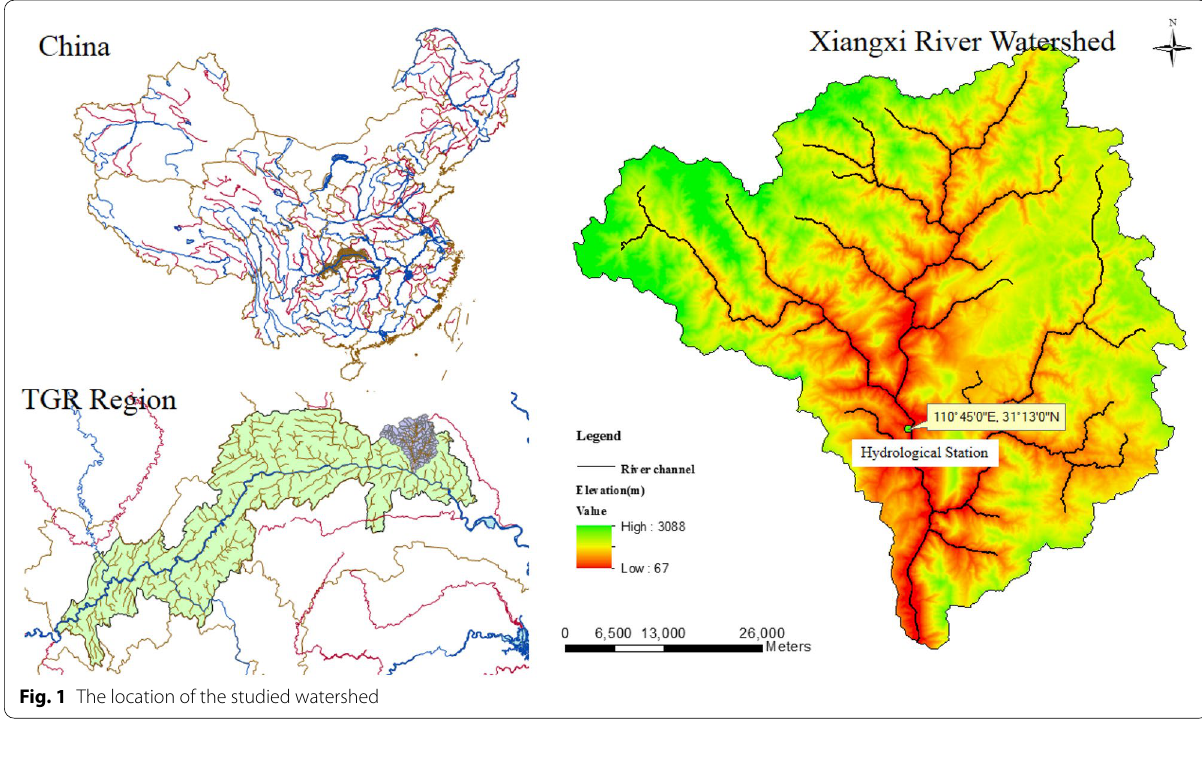
Fig. 1 The location of the studied watershed